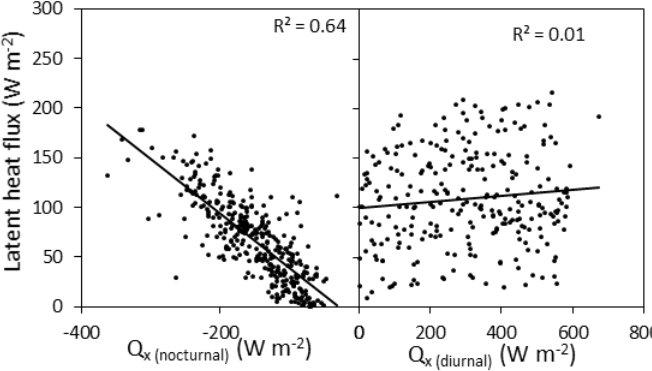
Figure 13. Relationship between latent heat flux and water heat flux ( 𝑄 𝑥 ) in nighttime ( left ) and daytime ( right ) range.